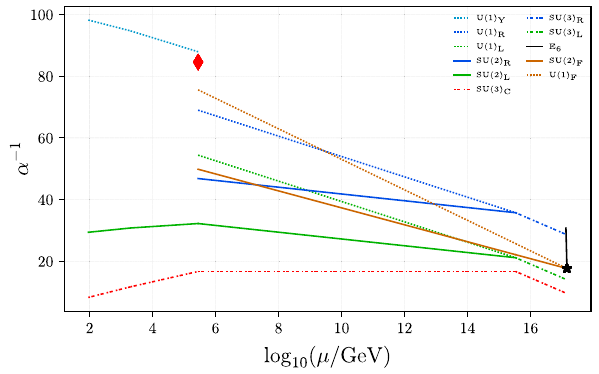
Fig. 9 Running of the gauge couplings in the SHUT model for the first point detailed in Table 8. This example represents scenarios with max- imal separation between the E 6 and trinification breaking scales. While the red diamond indicates the value of the flavour structure constant α − 1 ( M ) , the universal α − 1 ( M ) at the unification scale is represented S 8 T 8 by a black star